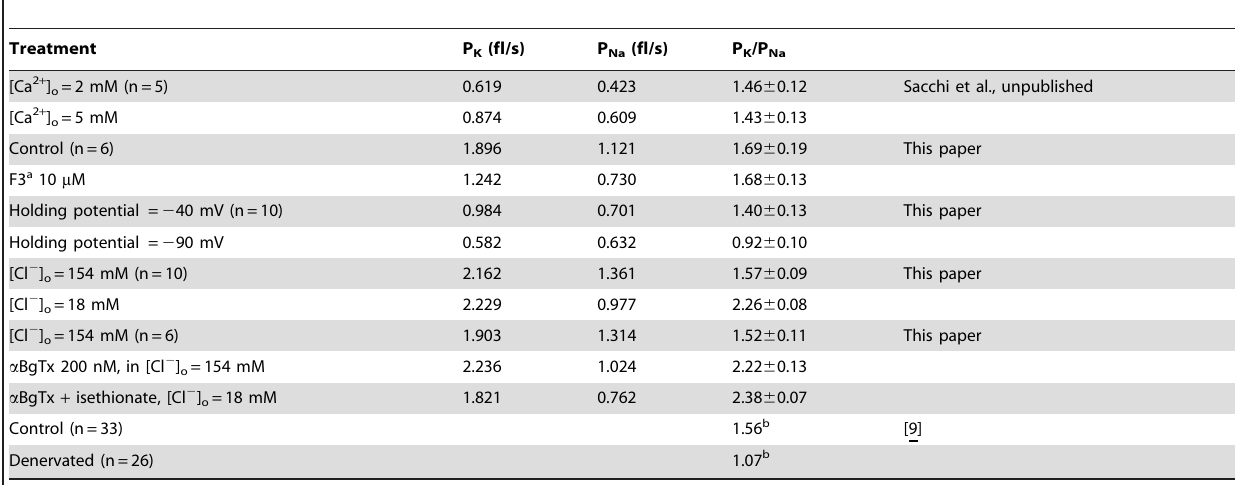
Table 2. Effect of different treatments on the permeation properties of the nicotinic channel at the ganglionic synapse.